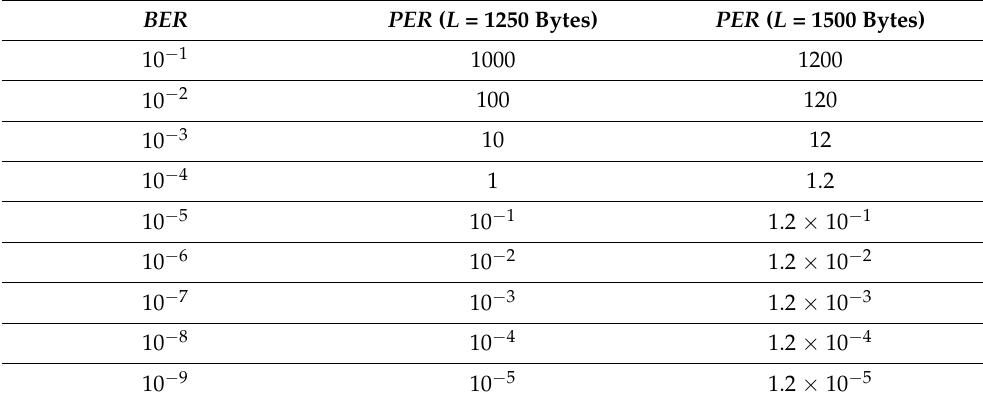
Table 1. Relationship between BER and PER for two different packet lengths.